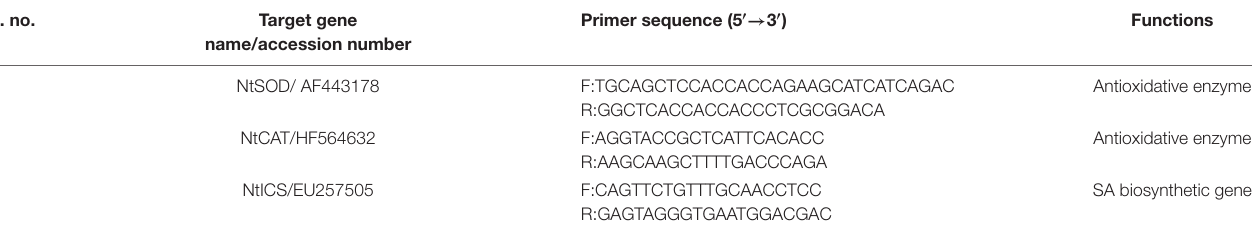
TABLE 1 | List of selected genes studied by real time PCR for transcript regulation in tobacco transgenics. S. no.